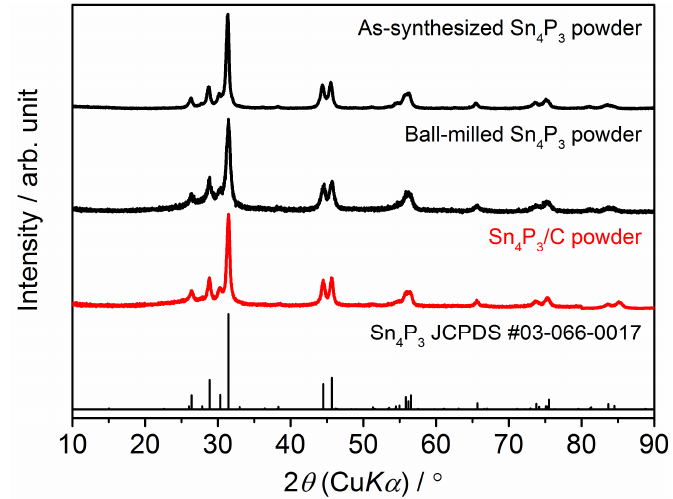
Figure 1. Comparison of X‐ray diffraction (XRD) patterns for as‐synthesized Sn 4 P 3 powder, ball‐milled Sn 4 P 3 powder and Sn 4 P 3 /C composite powder.